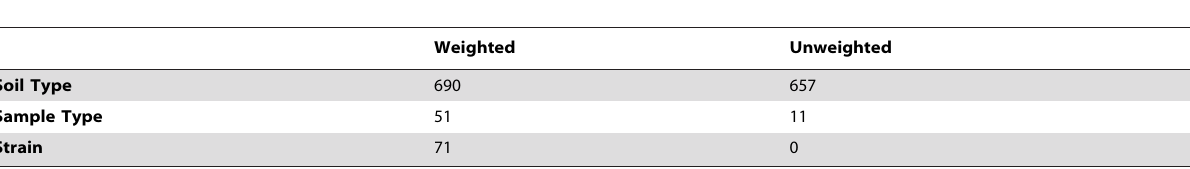
Table 2. Number of significant OTUs for soil type, sample type, and strain.